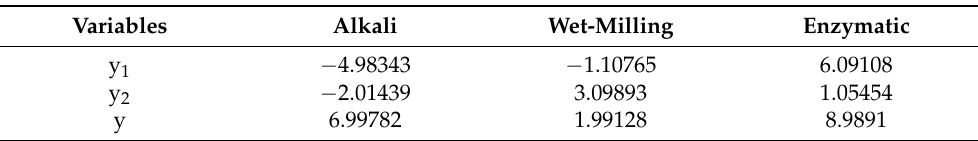
Table 4. Principal component analysis score of quinoa starch extracted by alkali, wet-milling, and enzymatic